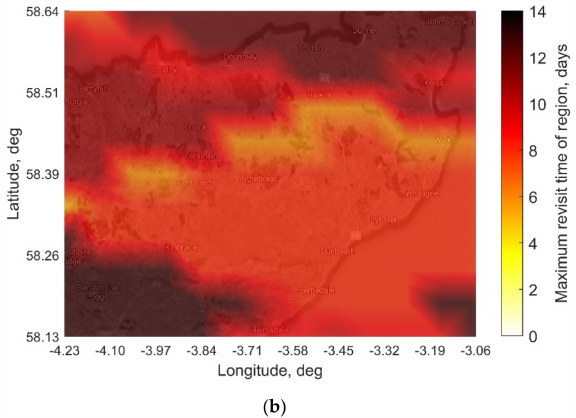
Figure5. MapsofthenorthregionofinterestasdescribedinTable6andindicatedonFigure2. Themapsare oriented with north to the top and cover an area of approximately 57 km (N-S) × 68 km (E-W). The colours overlaid on the maps indicate the ( a ) average and ( b ) maximum revisit times of each location in the region after 30 days. Coverage is calculated at approximately 5 km intervals and interpolated to provide the coverage estimates for the full region of interest (Map data: Google, TerraMetrics, www.google.com / maps